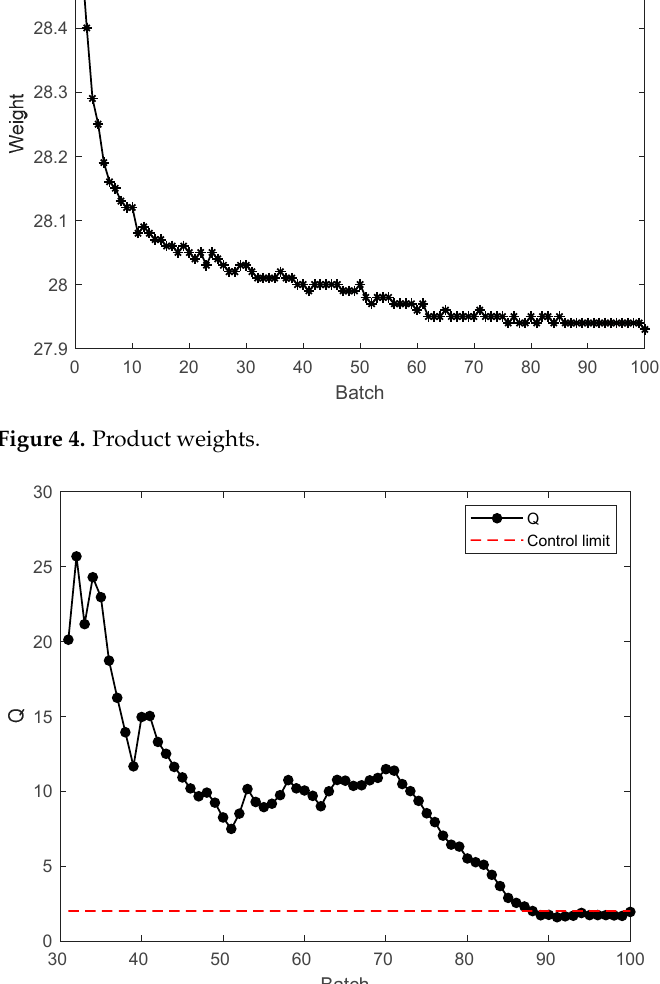
Figure 5. Judgment of product quality stability.